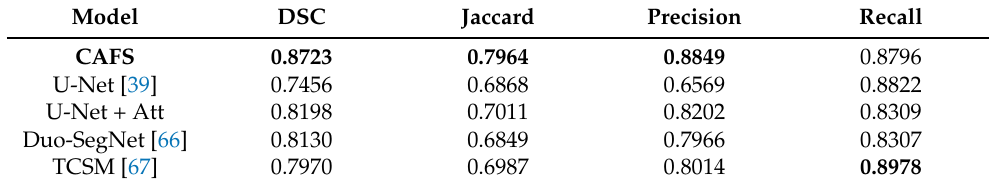
Table 5. Performance of CAFS and four other state-of-the-art models on the task of segmenting nasopharyngeal carcinoma. The training, testing, and validation processes for all five methods use the same data set distribution. We used four metrics to evaluate the performance of each model, DSC, Jaccard, precision, and recall, respectively. The higher the value of any metric, the better the model performs on the corresponding performance evaluation. The most optimal value of each metric is bolded in the table. It can be seen that, except for recall, the other three metrics of CAFS achieved the highest values.